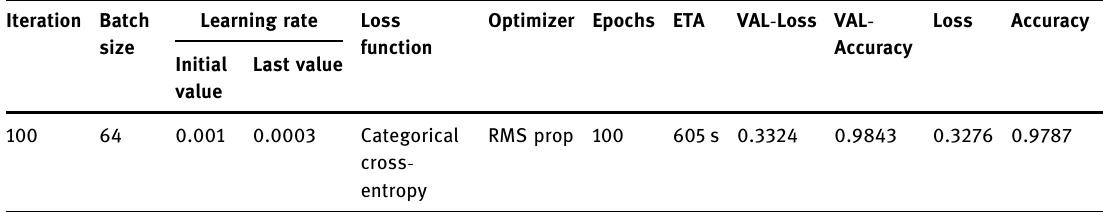
Table 5: Results in training phase